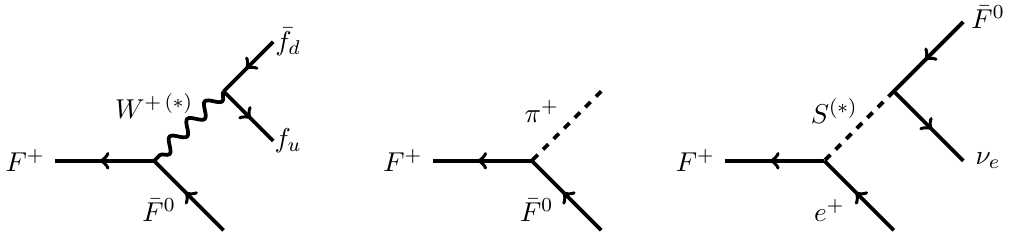
Figure 7 . Feynman diagrams for charged fermion F (cid:6) decays. f u ; f d stand for Standard Model up or down type quarks or leptons. The decays through a W (cid:3) (left) or the two body decays into (cid:25) (cid:6) (center) are set by the fermion’s quantum numbers, while the singlet-mediated decay width (right) is controlled by the coupling (cid:20) and the scalar singlet mass m S . In the singlet-mediated diagram, both (cid:22) F 0 (cid:23) e and F 0 (cid:22) (cid:23) e (cid:12)nal states are possible.